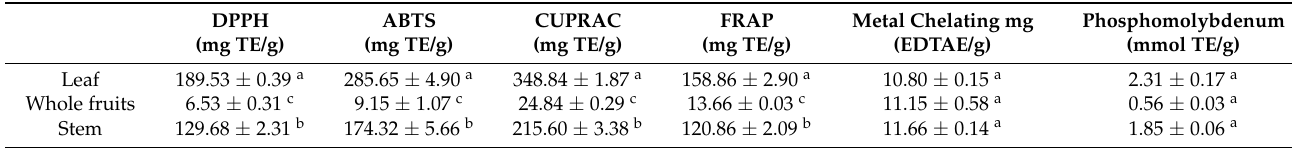
Table 2. In vitro antioxidant assays of different Cydonia oblonga mill. extracts